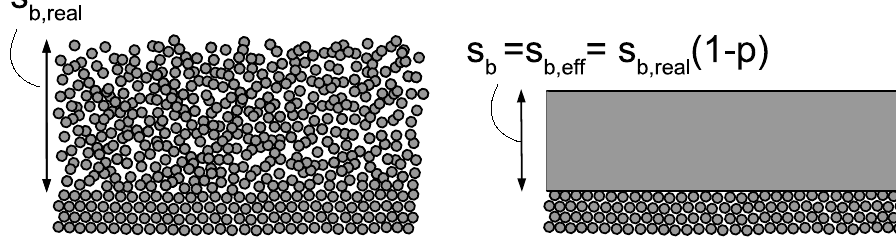
Figure 3. Bed-load layer, real and e ff ective thicknesses